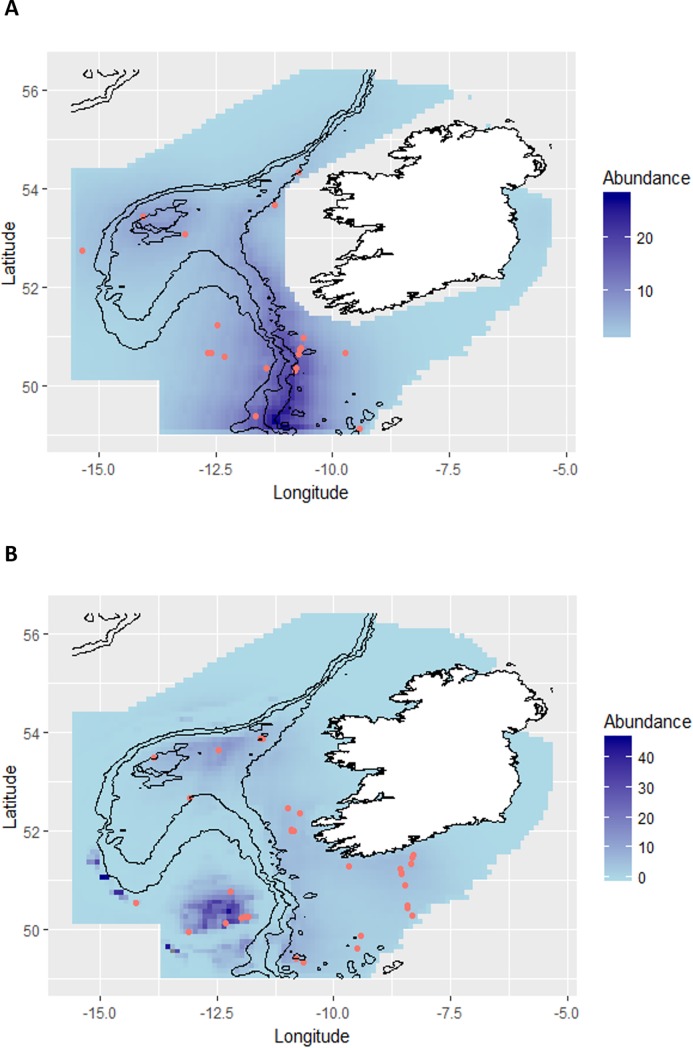
Predicted abundance for blue sharks in the survey area (A) in summer 2015, and (B) in summer 2016, corrected with modelled availability bias. Red circles denote blue shark sighting locations. The contours shown are 200m, 500m, and 1000m depth contours.